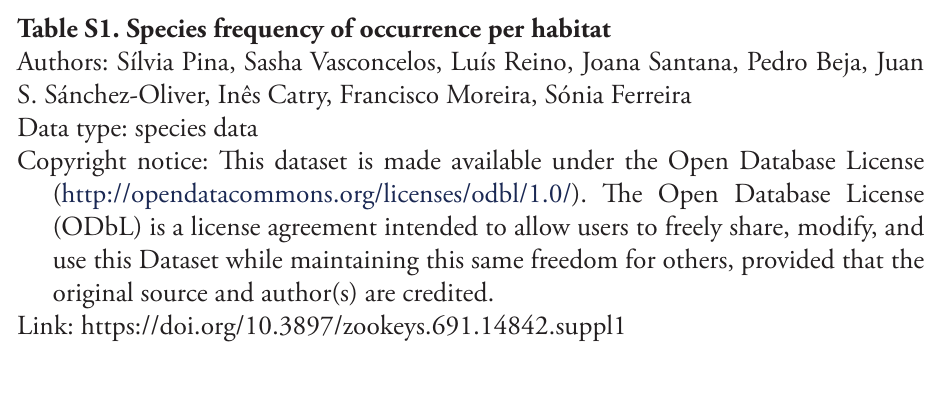
Table S1. Species frequency of occurrence per